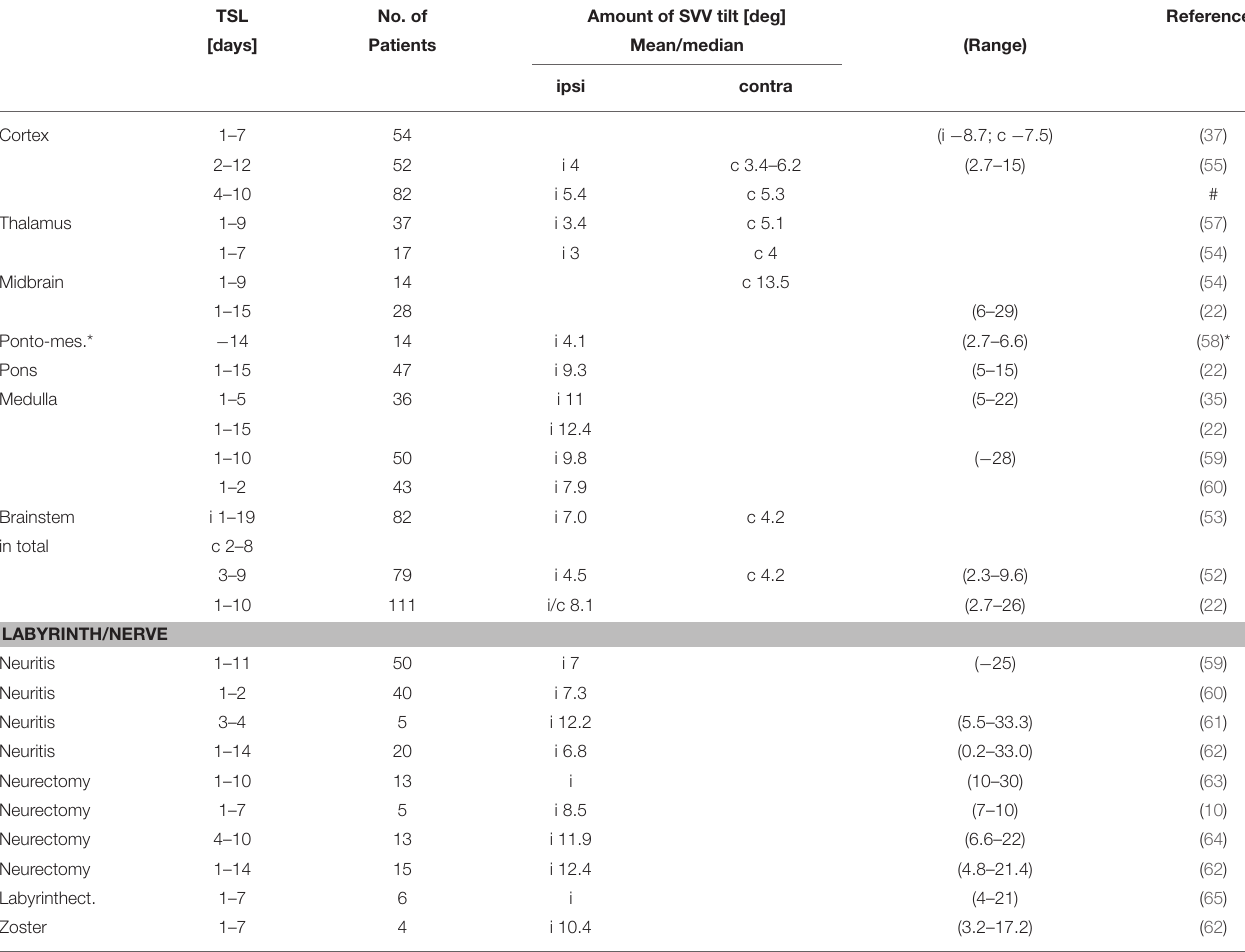
TABLE 1 | SVV tilts in acute unilateral vestibular lesions at different lesion sites from labyrinth to cortex (i, ipsilateral tilt; c, contralateral tilt). TSL No. of Amount of SVV tilt